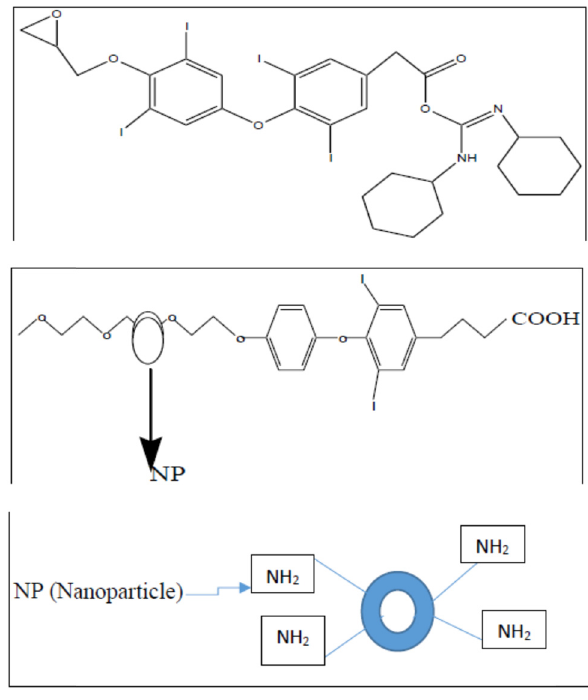
Figure 7: Nano - Tetrac drug model.